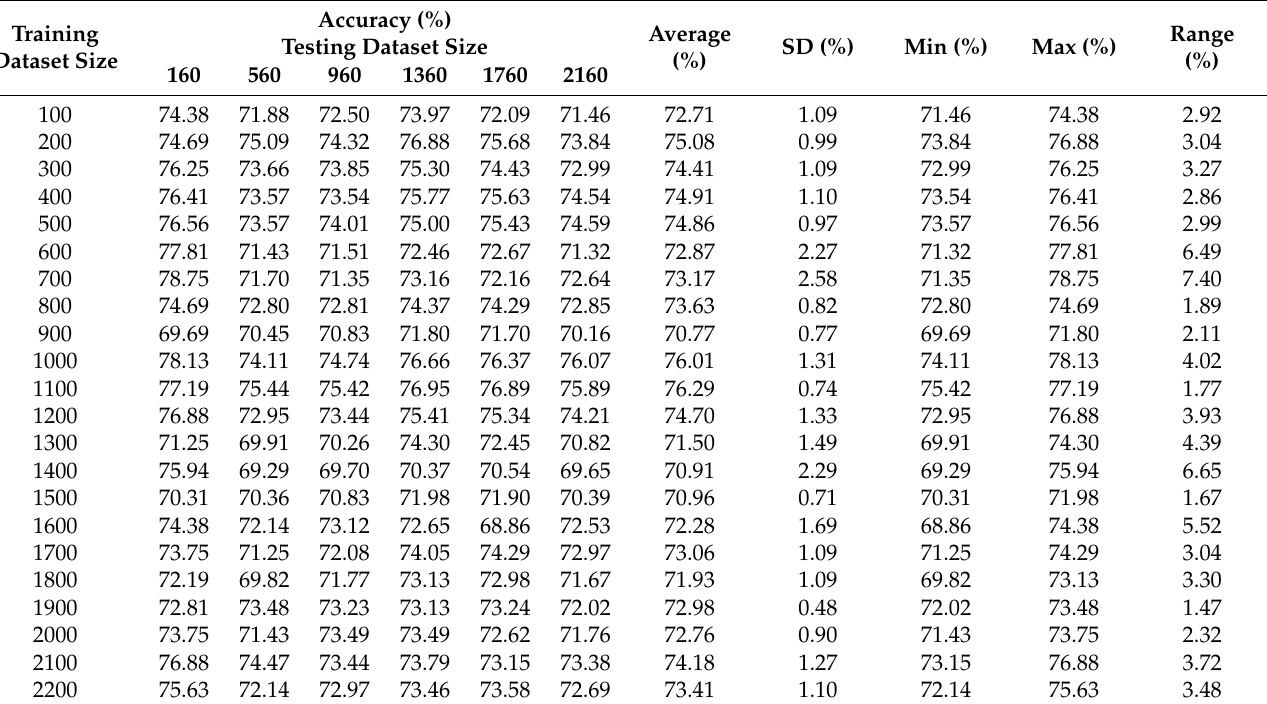
Table 6. Comparison of classification accuracy of different size testing datasets for Scenario